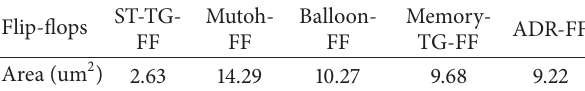
Table 6: Area of different